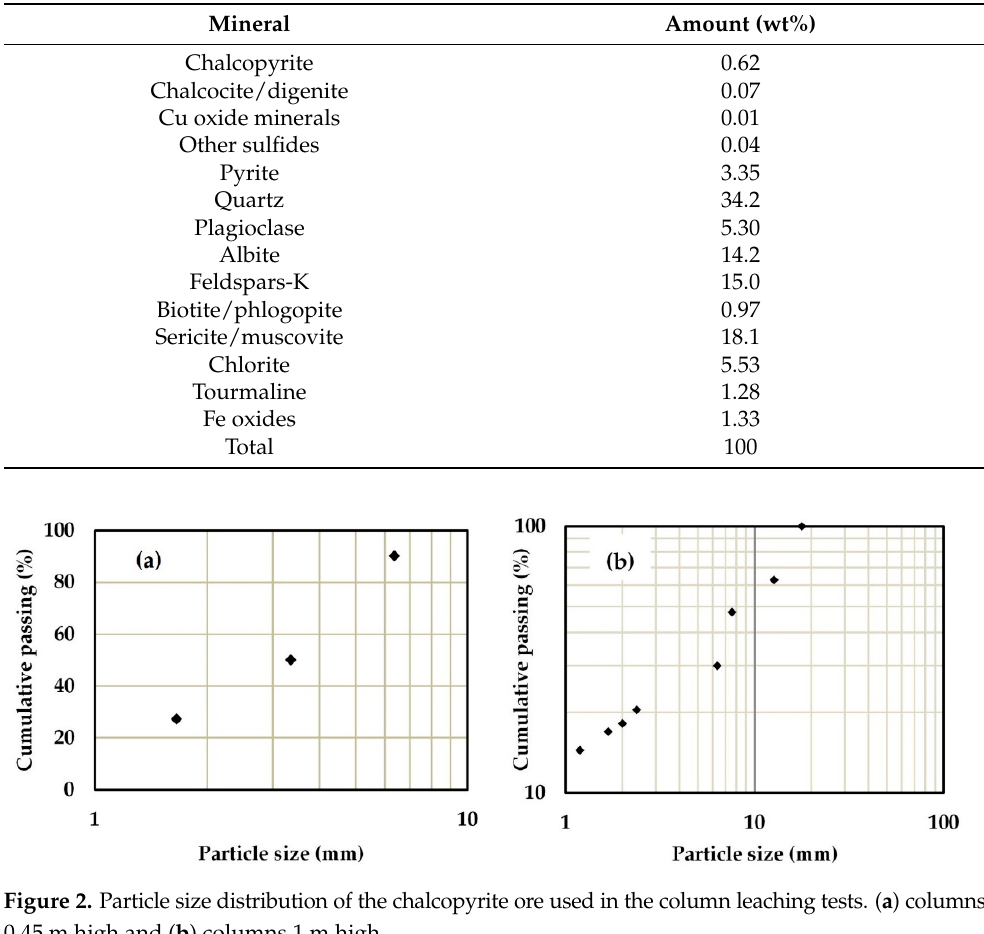
Figure 1. Mineralogical distribution of the copper-bearing sulfide minerals in the ore (amount in wt % and 100% base copper species). Table 1. Mineralogical composition of the ore obtained by QEMSCAN analysis Table 1. Mineralogical composition of the ore obtained by QEMSCAN analysis.